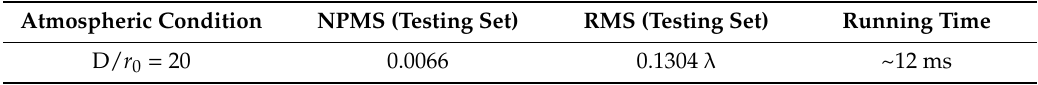
Table 3. The model indicators of the experiment (D/r 0 =